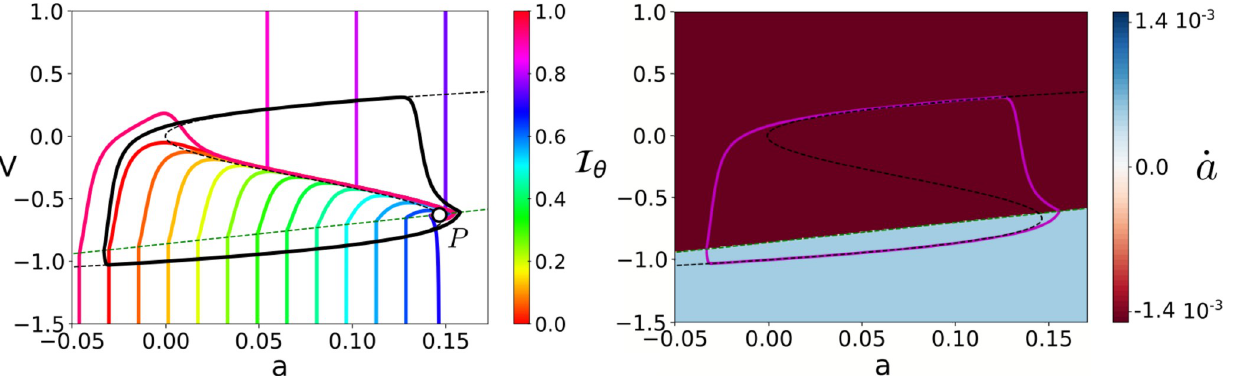
Fig 5. Relationship between the curvature of isochrons and the values for the slow vector field. For the phenomenological epilepsy model (7) with the set of parameters P in (8) the figure shows: (A) Limit cycle Γ pheno and its isochrons I pheno (7)) for points z 2 W